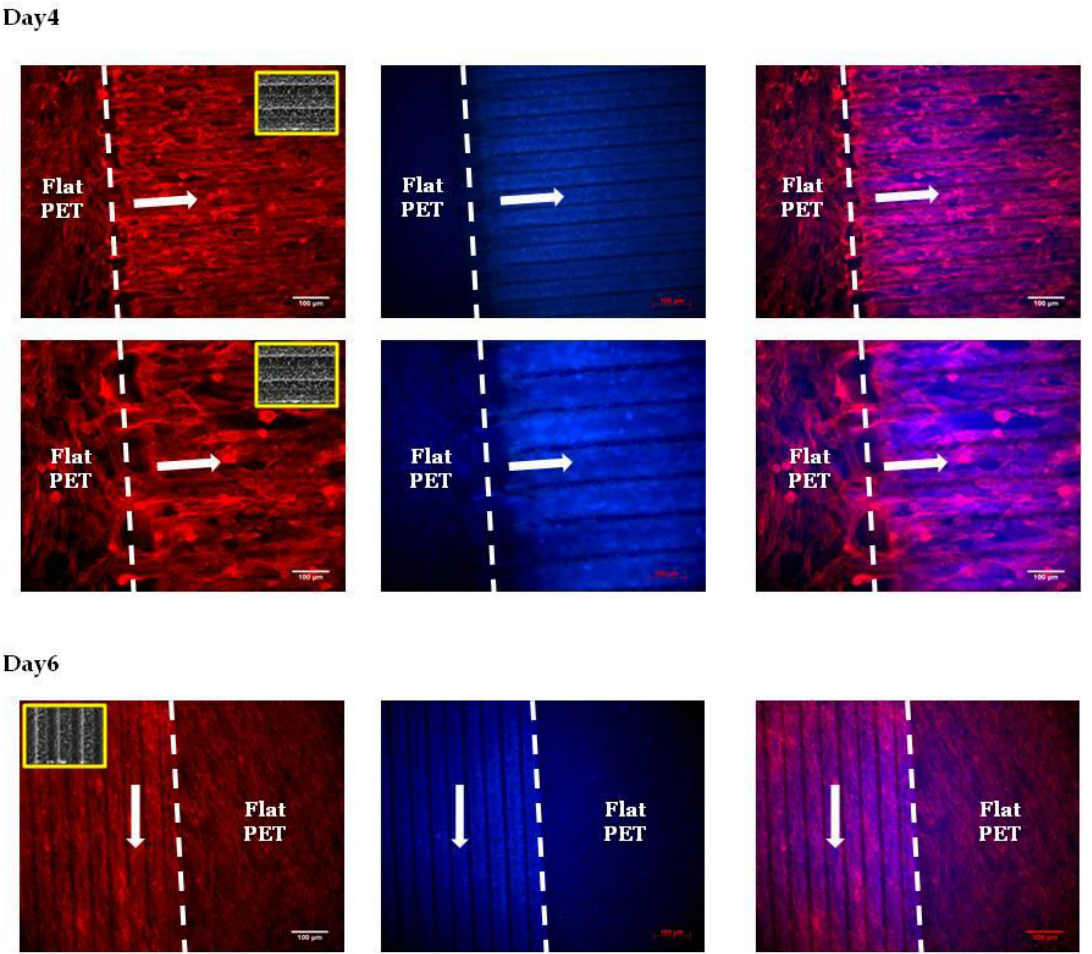
Figure 7. Fluorescent images of Schwann cells cultured on the PET substrates (PET-MG and PET-Flat) for 4 and 6 days. The cytoskeleton of the cells is visualized with red color (Alexa Fluor ® 568 Phalloidin), while the nuclei are indicated with blue color (DAPI). The white arrows represent the directionality of Schwann cytoskeleton, which is according to the direction of the microgrooves. The inset SEM images, indicated by the yellow box, show the geometry of microgrooves.